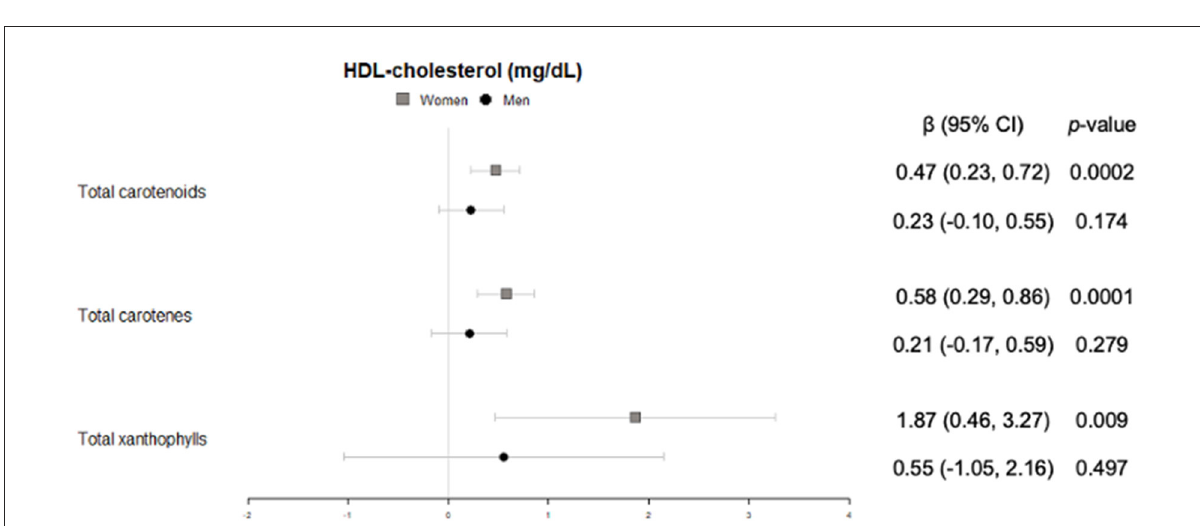
FIGURE7 Cross-sectional association of plasma carotenoids and subclasses (per unit increase) with blood HDL-cholesterol (mg/dl) (95%-CI), and their respective p